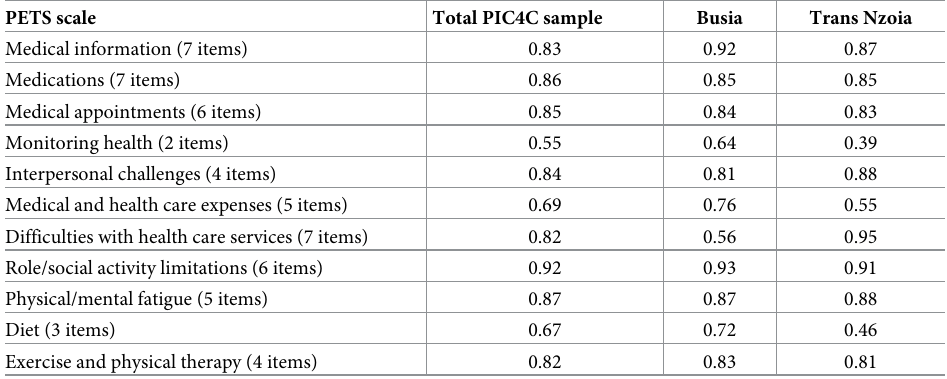
Table 2. Reliability (Cronbach’s α ) of PETS domains